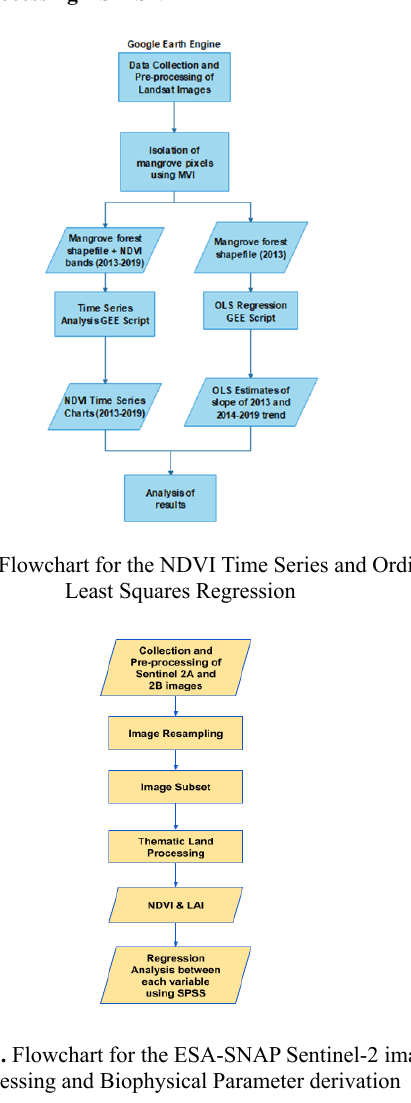
Figure 1 . Map showing the track of typhoon Haiyan (left), and Lawaan-Balangiga, Samar and its coastal barangays 3.2 Time series analysis using Google Earth Engine and LAI processing ESA-SNAP